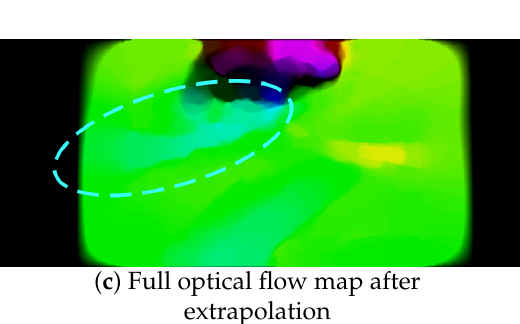
( b ) Optical flow alignment: → optical flow calculated in the overlap area (cid:57)(cid:57)(cid:75) optical flow extrapolated outside the overlap area. Dark blue dashed lines delimits the central area.